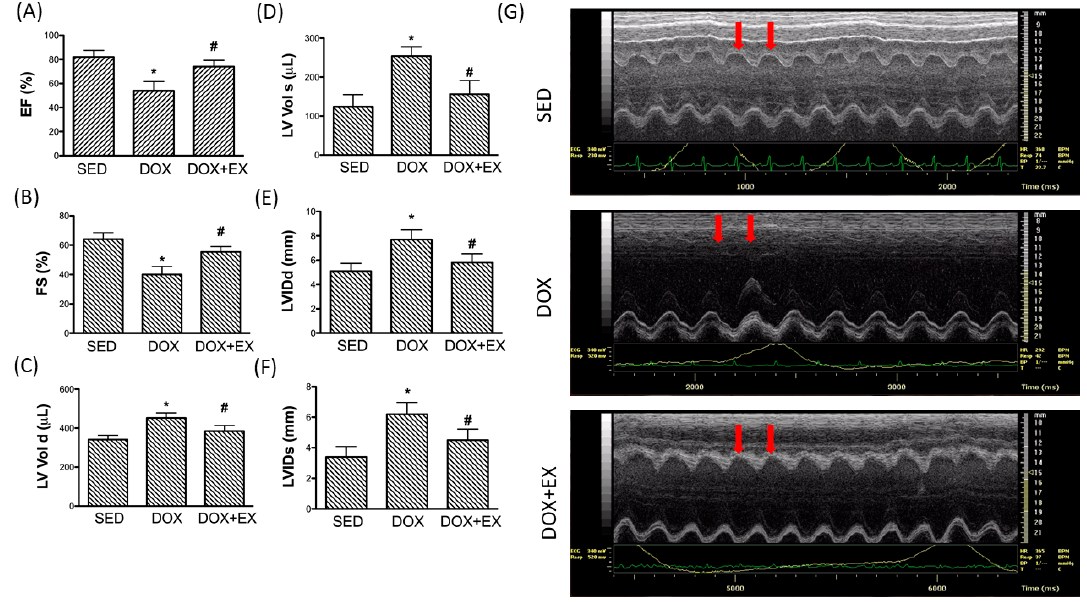
Figure 5. Examination of cardiac function using echocardiography: ( A ) ejection fraction; ( B ) fractional shortening; ( C ) left ventricular end-diastolic volume; ( D ) left ventricular end-systolic volume; ( E ) left ventricular internal dimension in end-diastole; and ( F ) left ventricular internal dimension in end-systole; ( G ) Representative echocardiographic M-mode images from animals. * p <0.05 compared to the SED group. # p <0.05 compared to the DOX group.